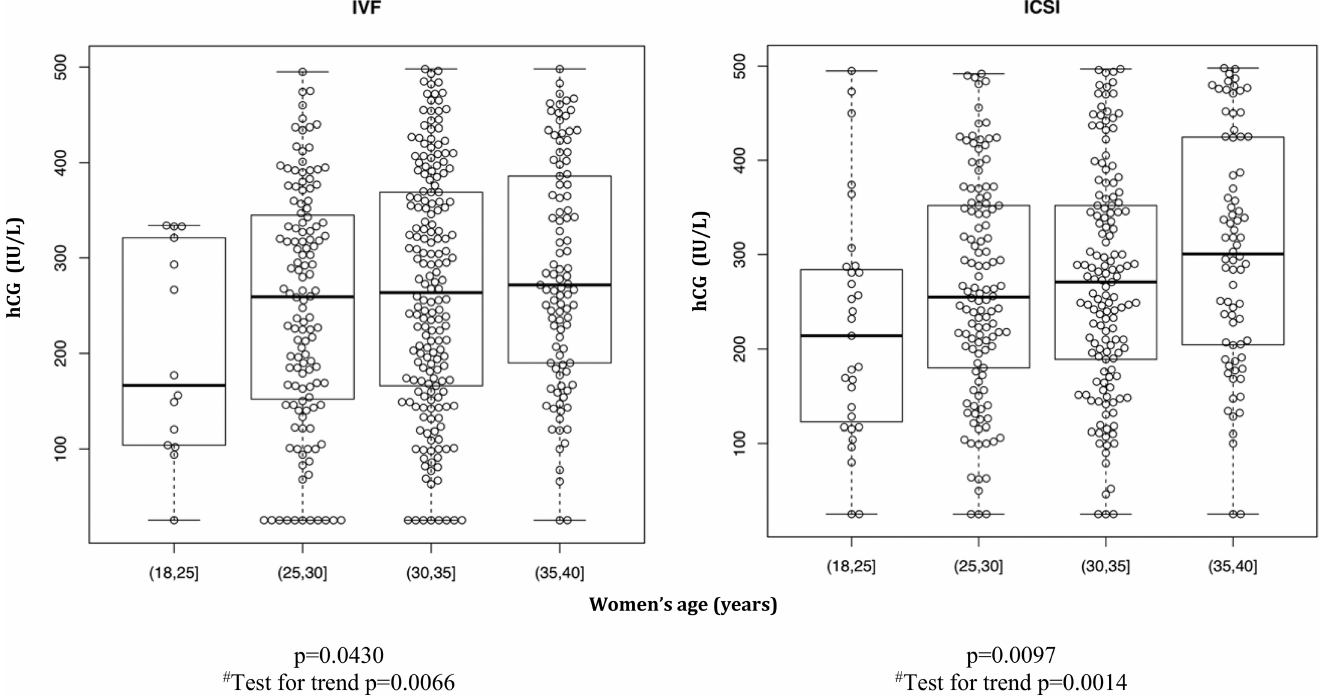
Fig 1. The initial rise * in hCG after single embryo transfer in IVF and ICSI treatmentsresulting in ongoing clinical pregnancy with fetal heart beat (week 7–8) increasessignificantly with increasing women’s age. * hCG in blood plasma 14 days after day-2 transfer. Number of observations: IVF: 429; ICSI: 374. # Modeling age groups in a linear